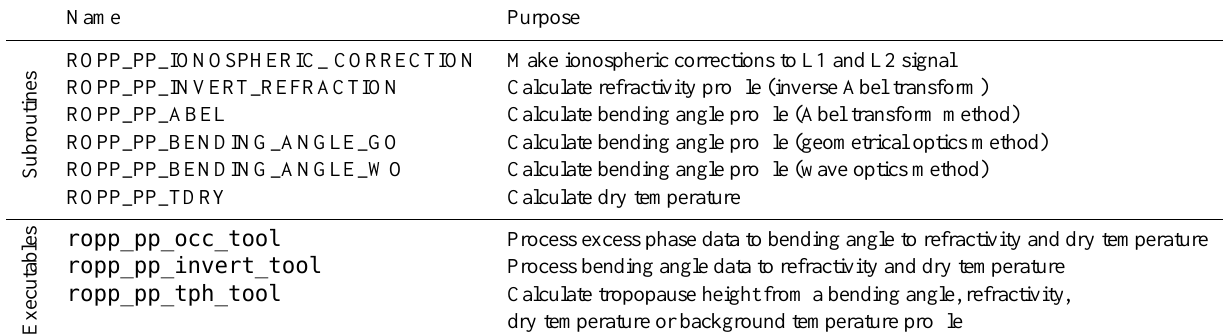
Table 4. Subroutines and standalone executables in the ROPP PP